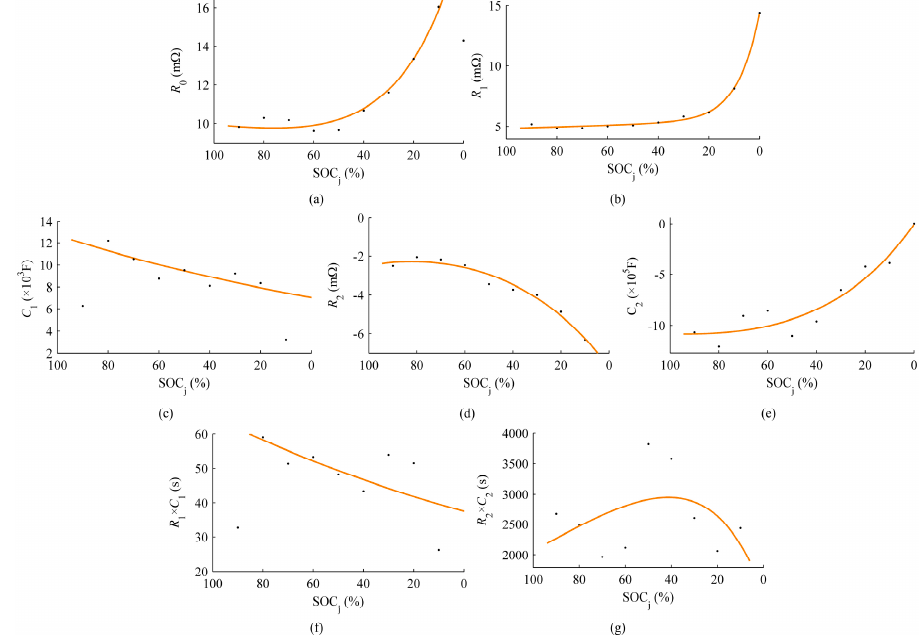
Figure 9. Identified ( a ) R 0 ; ( b ) R 1 ; ( c ) C 1 ; ( d ) R 2 ; ( e ) C 2 ( f ) R 1 × C 1 and ( g ) R 2 × C 2 under { i 1 = − 14.3 A, i 2 =